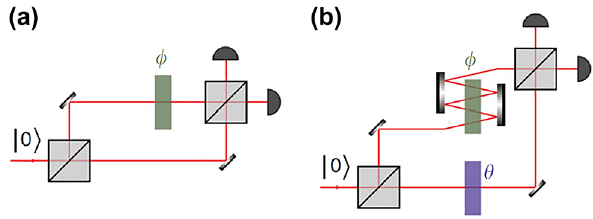
Figure 6: Mach-Zehnder interferometer (MZI). (a) ConventionalMZI setup with input state | 0 ⟩ and phase difference ϕ between the two arms. The intensity at each detector oscillates as a function of ϕ allowing the phase to be measured. (b) An adaptive interferometerisimplementedbyaddingavariablephaseelement θ which is controlled to operate the interferometer at the maximum sensitivity. Adapted from the study by Daryanoosh et al. [134]